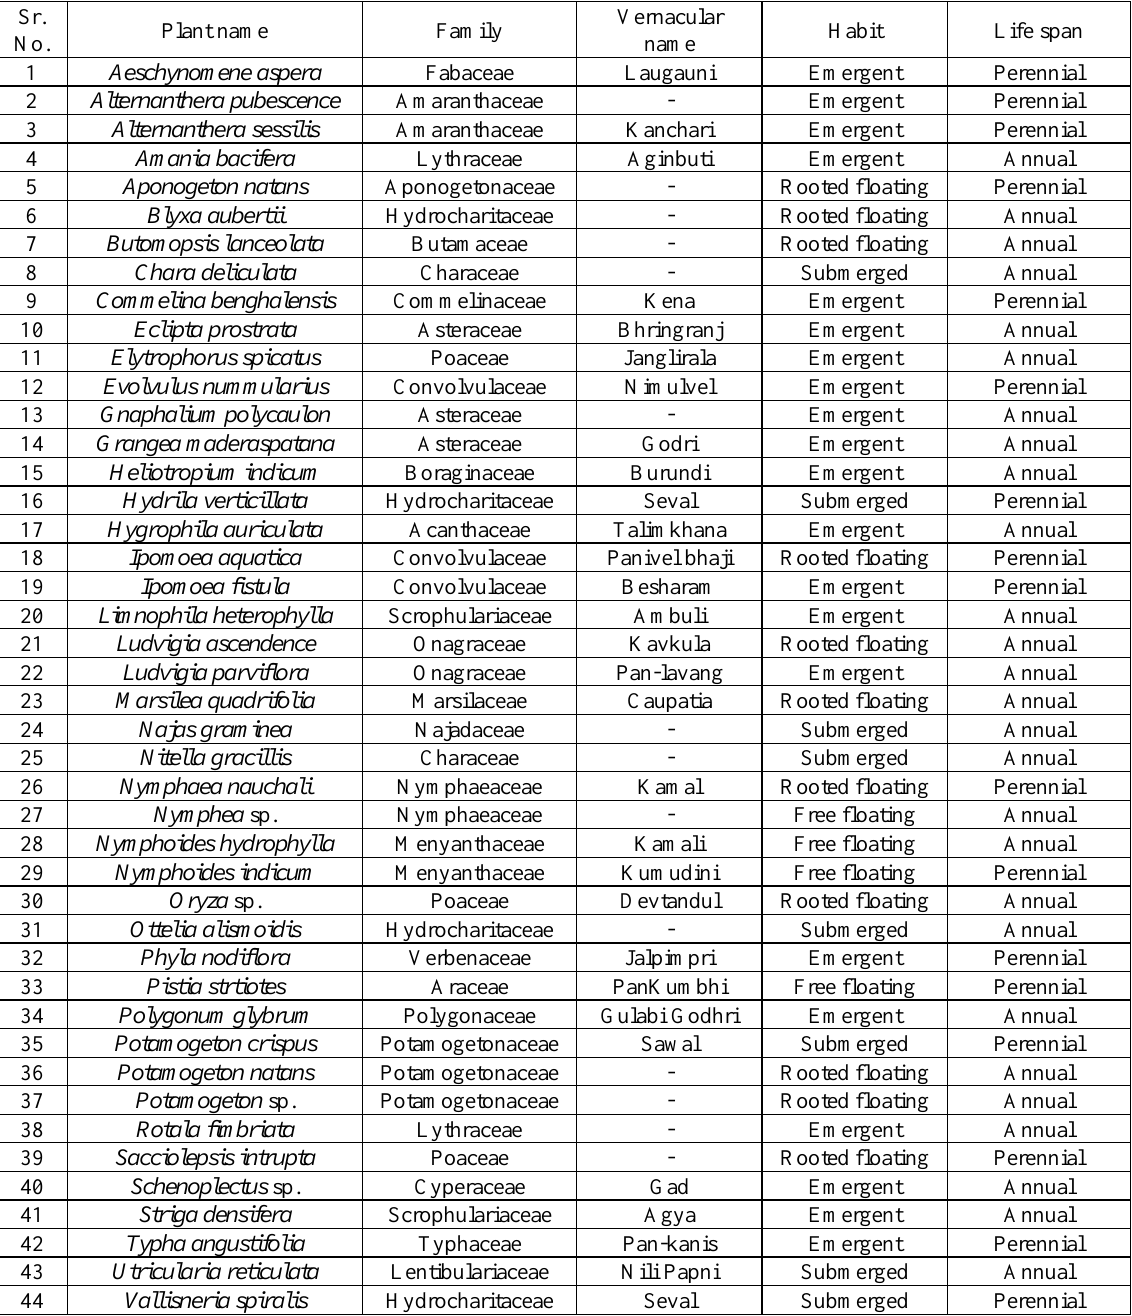
Table 3. Details of plants observed in the study